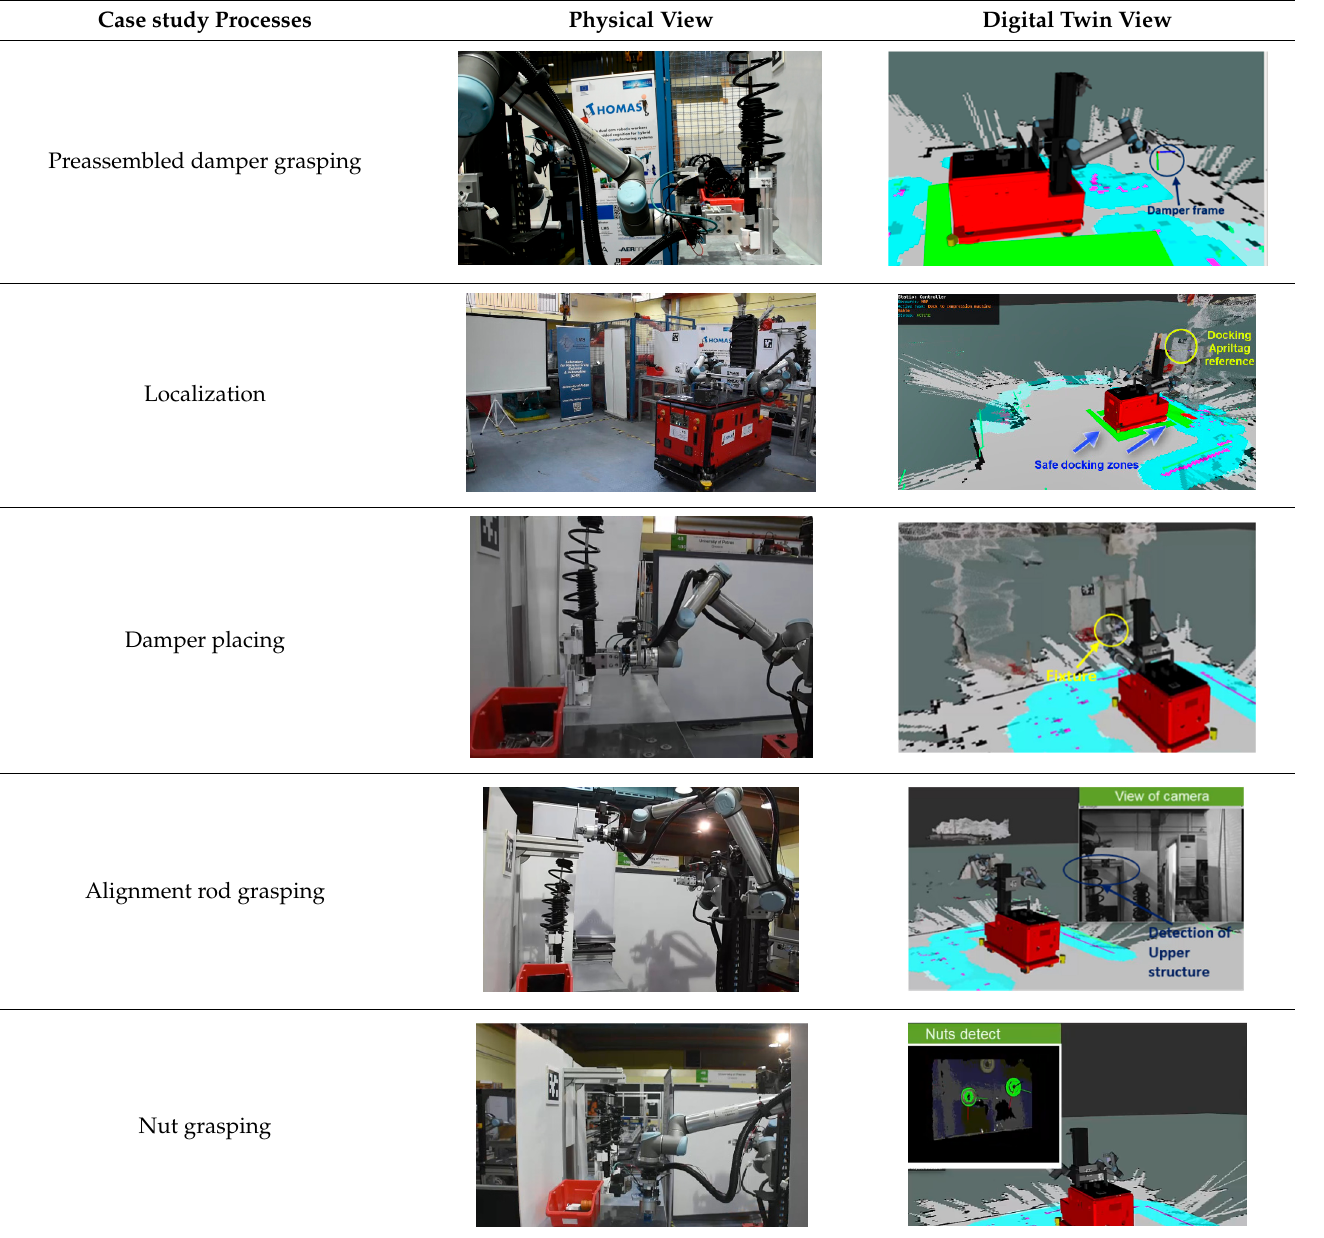
presented in this work were of vital importance for the implementation of the use case.